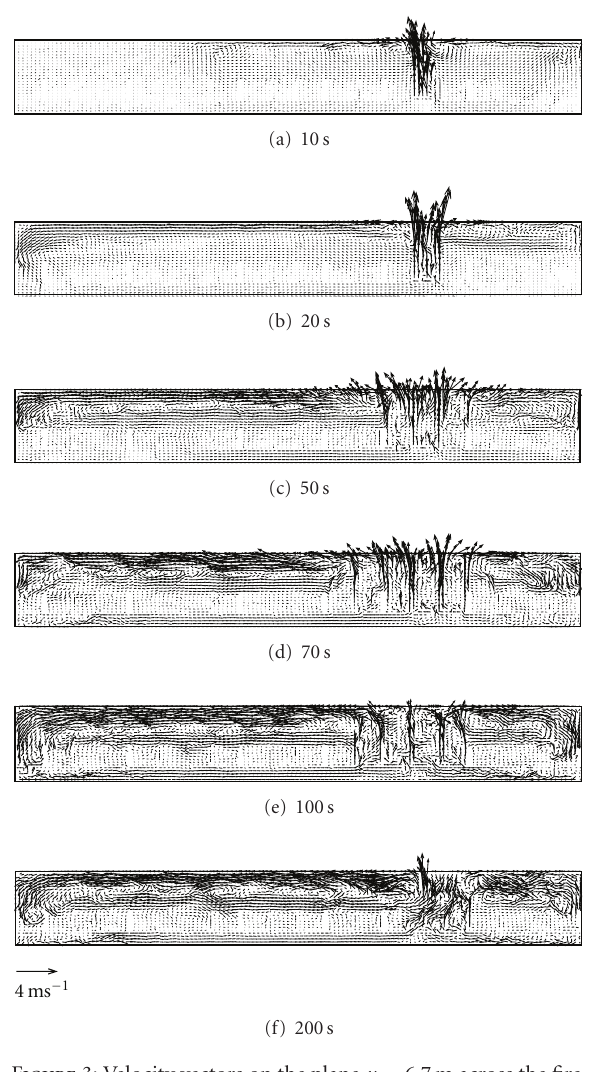
Figure 3: Velocity vectors on the plane y = 6 . 7m across the fire.